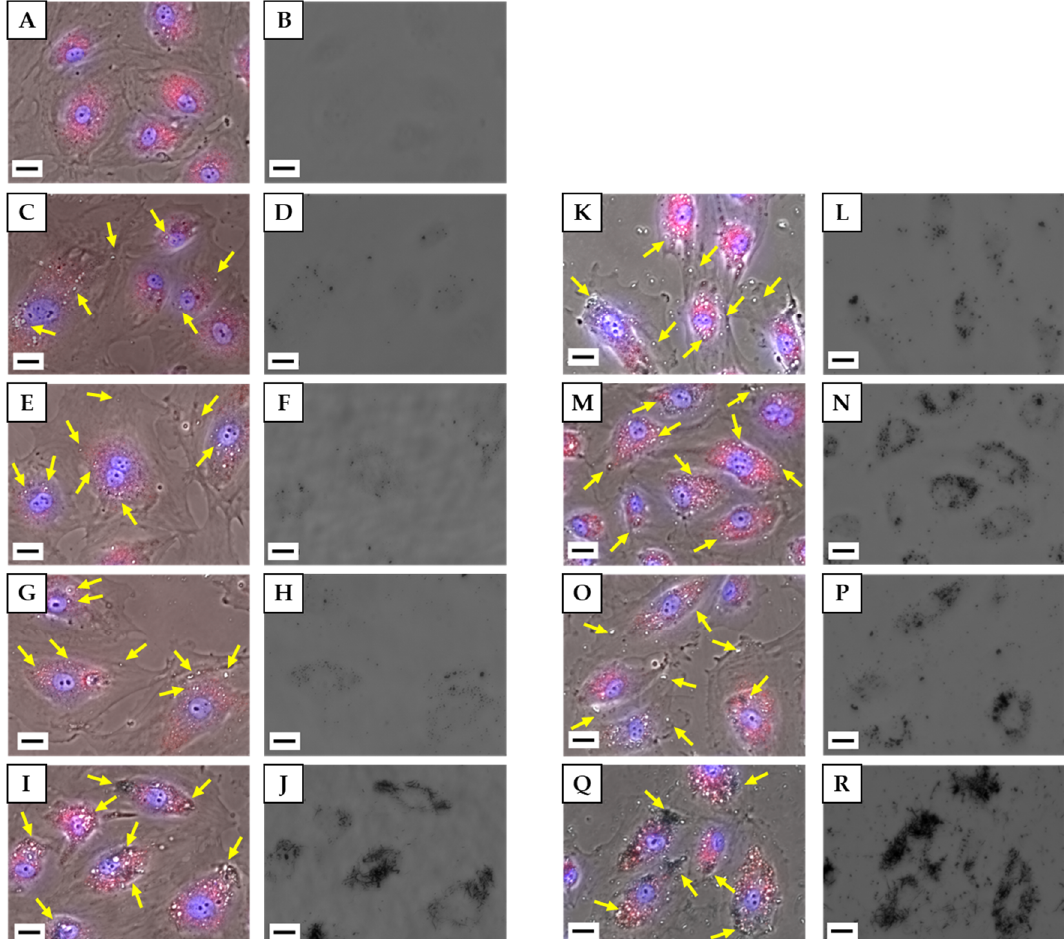
Figure 4. Live HLEC images after incubation with H33342 for nuclear staining and CytoPainter LysosomalStaining Kit for lysosomes. ( A,B ) Control, ( C,D,K,L ) unCNH, ( E,F,M,N ) oxCNH, ( G,H,O,P ) CB, ( I,J,Q,R ) MWCNT. ( A,C,E,G,I,K,M,O,Q ) Image obtained by merging the phase contrast image and the fluorescence images. ( B,D,F,H,J,L,N,P,R ) Bright field image. ( C – J ) 10 µg/mL. ( K – R ) 100 µg/mL. Scale bars correspond to 20 µm. Yellow arrows indicate CNMs. HLEC, human lymphatic endothelial cell; H33342, bisbenzimide H33342 fluorochrome trihydrochloride; unCNH, untreated carbon nanohorn; oxCNH, oxidized carbon nanohorn; CB, carbon black; MWCNT, multi-walled carbon nanotube; CNMs, carbon nanomaterials.